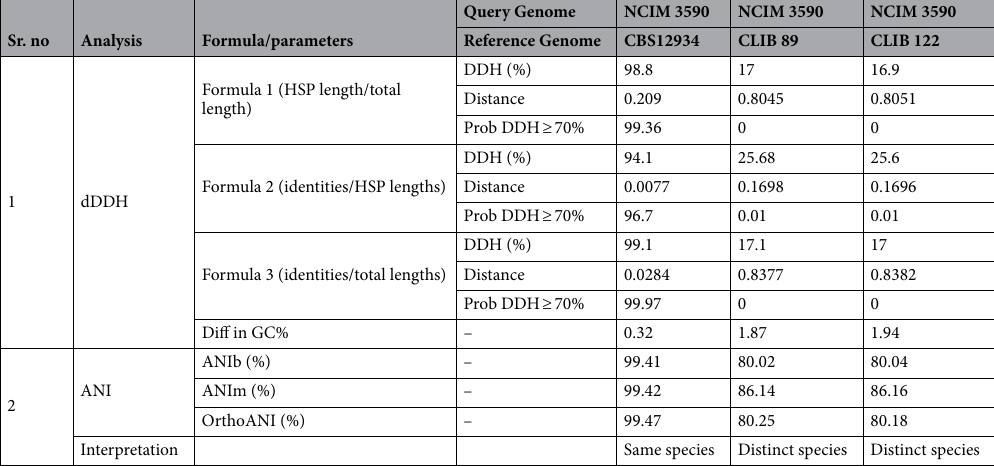
Table 3. Genomic relatedness using dDDH and ANI of NCIM 3590 with CBS 12934 and with two reference strains CLIB 122 and CLIB 89.